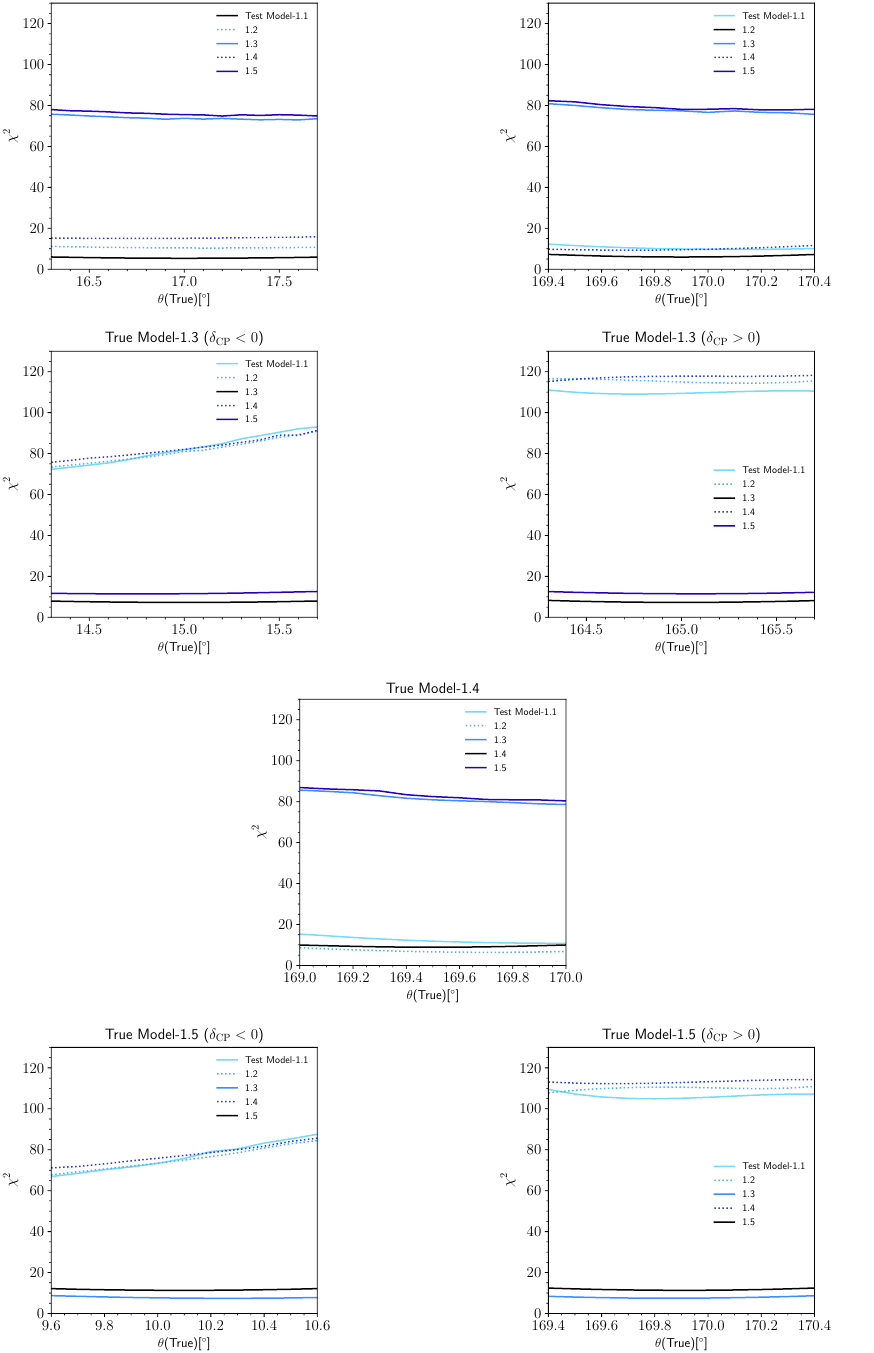
Figure 3 . Comparison among the (cid:12)ve allowed one-parameter models as test models for ESSnuSB using priors. Each panel shows the quantity (cid:31) 2 , given a true model, as a function of the model min parameter (cid:18) in its 3 (cid:27) interval (cid:18) 3 (cid:27) presented in table 8. In each panel, (cid:31) 2 for the given true model min is displayed with a black solid curve (when acting as a test model), whereas it is marked for the (cid:12)ve test models by curves corresponding to their respective model colors.